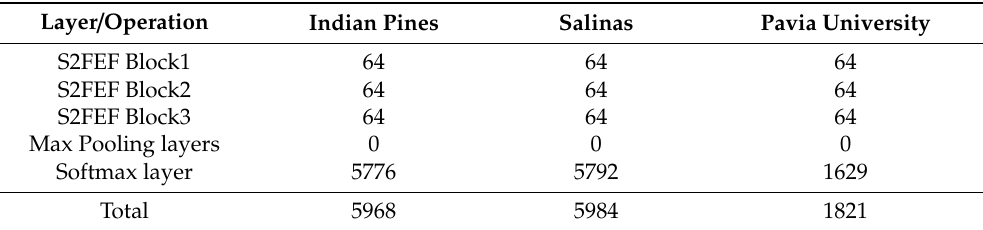
Table 2. Number of parameters in the S2FEF-CNN architecture for di ff erent datasets.